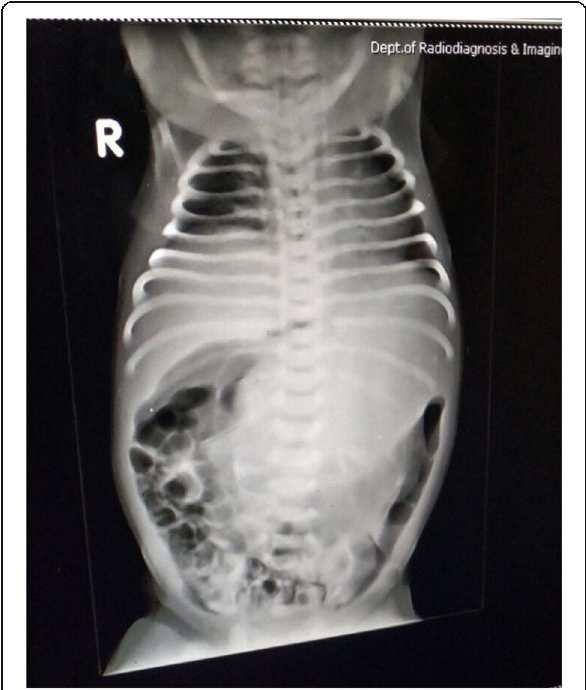
Fig. 1 Thoracic and abdominal X-ray revealed a gaseous bowel distension in the right flank and inferior abdomen, with opacity in the rest of the